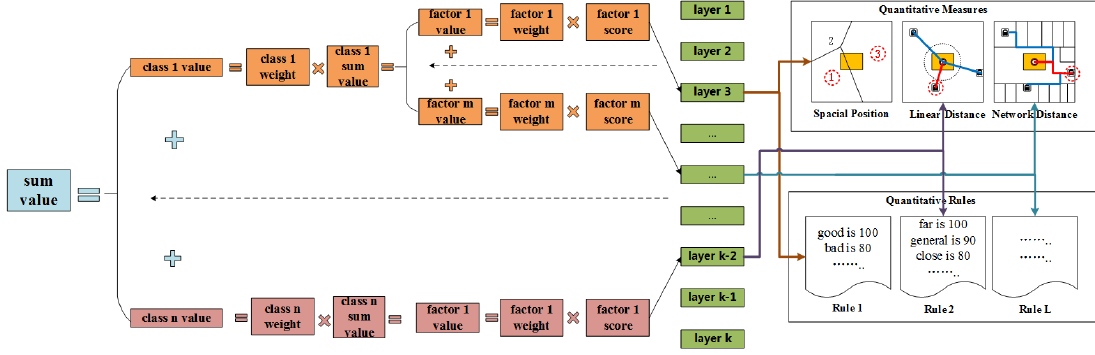
Figure 4. Quantification process.